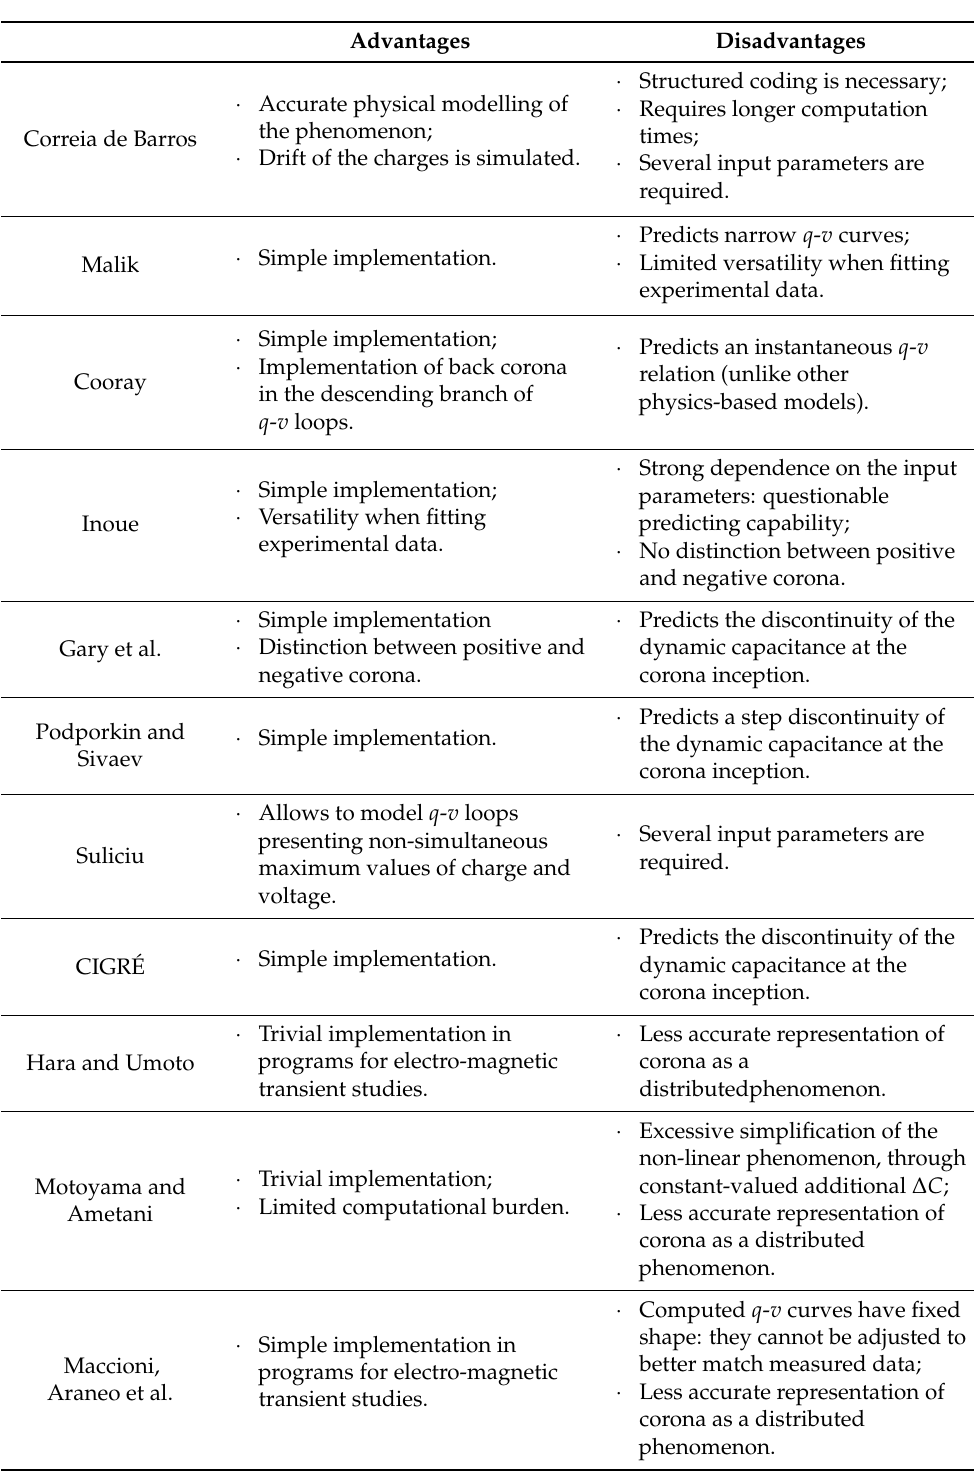
Table 7. Features of the reviewed